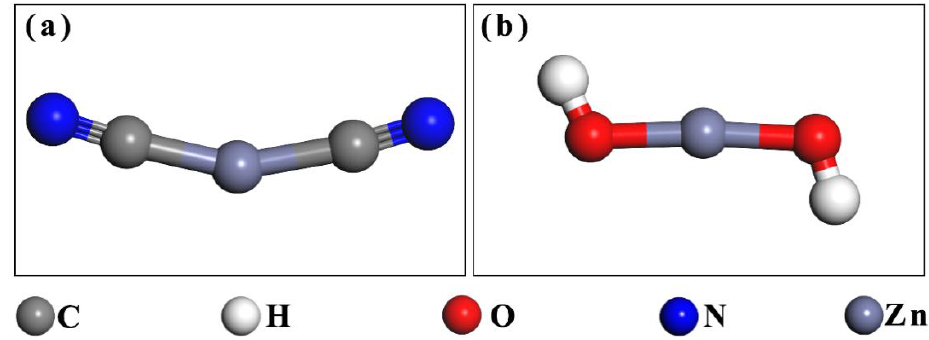
Figure 3. ( a ) Zn(CN) 2 and ( b ) Zn(OH) 2 models after geometric optimization.